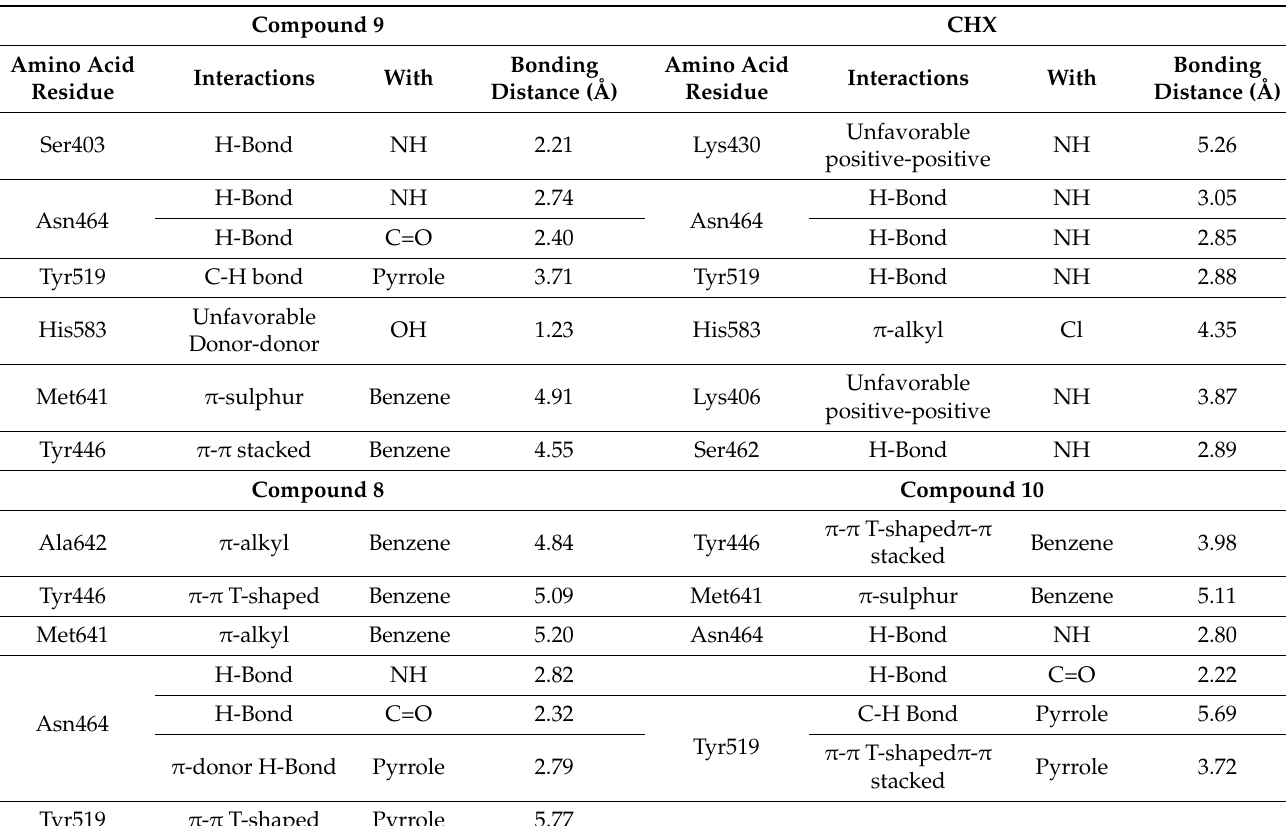
Table 4. Data of interactions resulting from the molecular docking of compounds 8 , 9 , 10 , and CHX into PBP2a. Compound 9